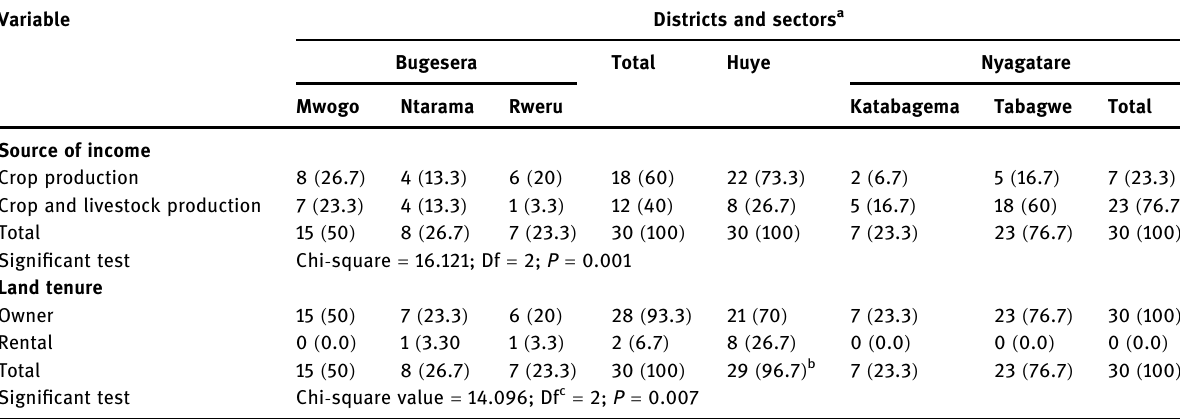
Table 1: Sources of incomes and land tenure among respondents in the three districts of Rwanda